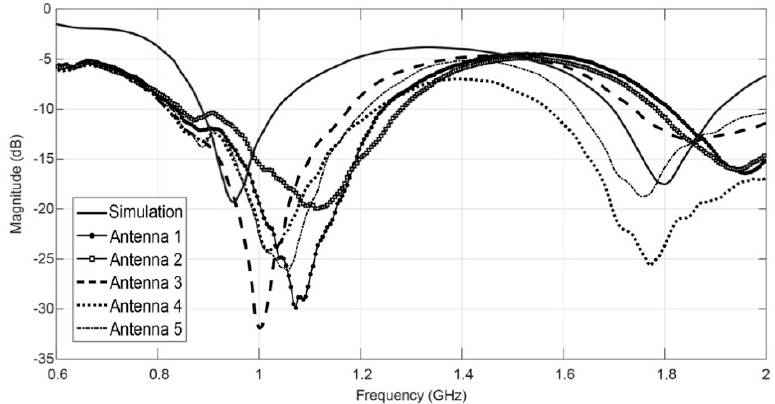
Figure 6. Simulated and measured return loss of embroidered antennas.